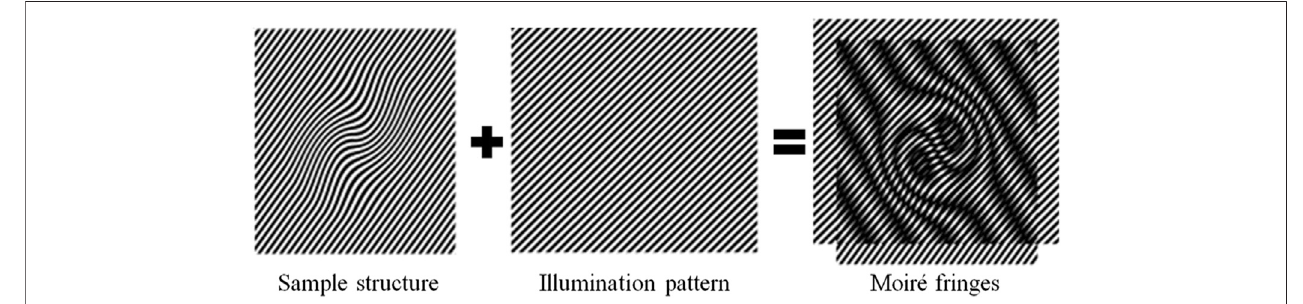
FIGURE 1 | Generation of Moiré fringes. If the sample structure is multiplied by structural light, Moiré fringes will